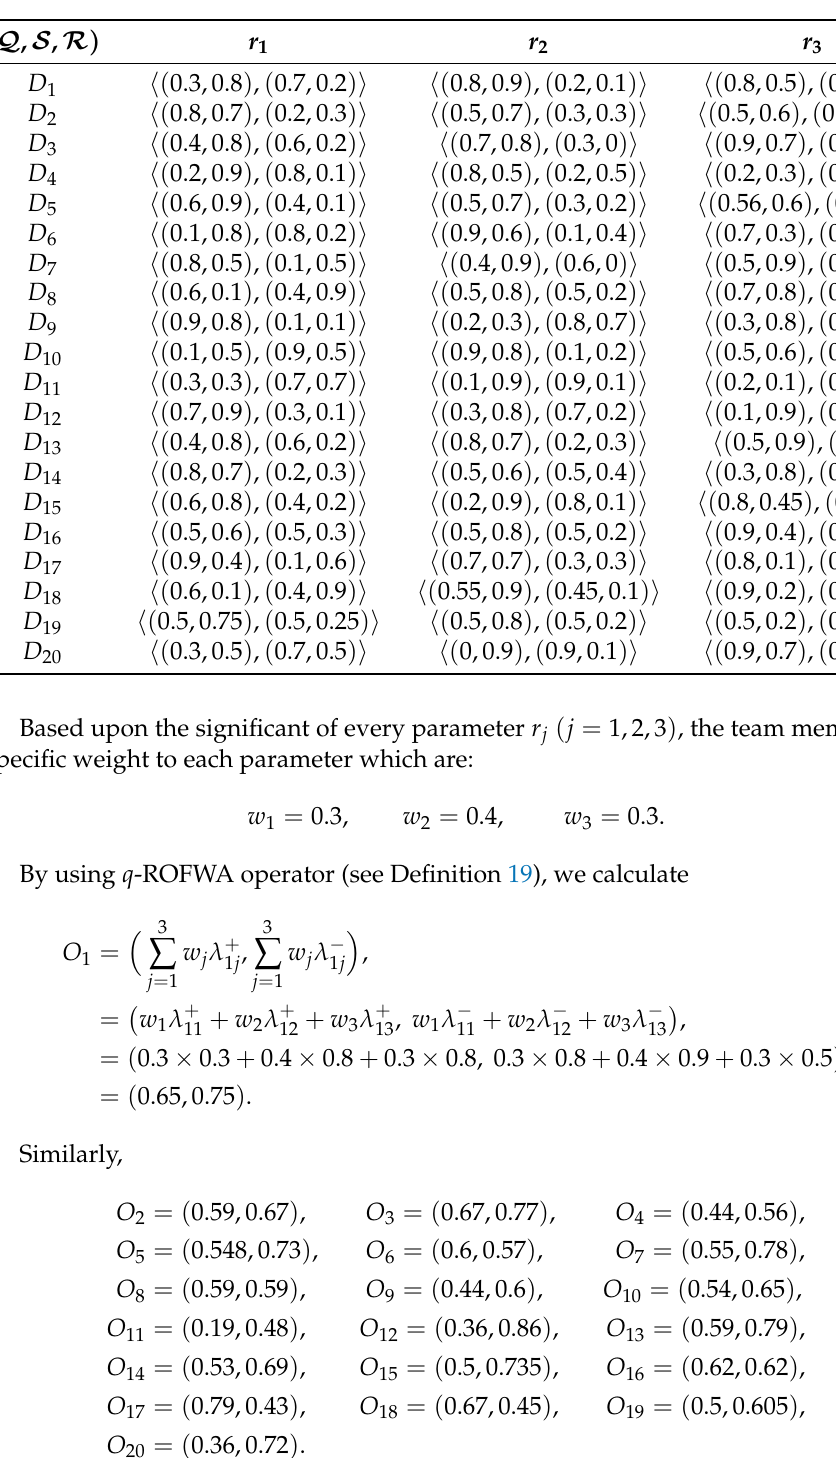
Table 16. Table for the 5-ROFBSS ( Q , S , R )